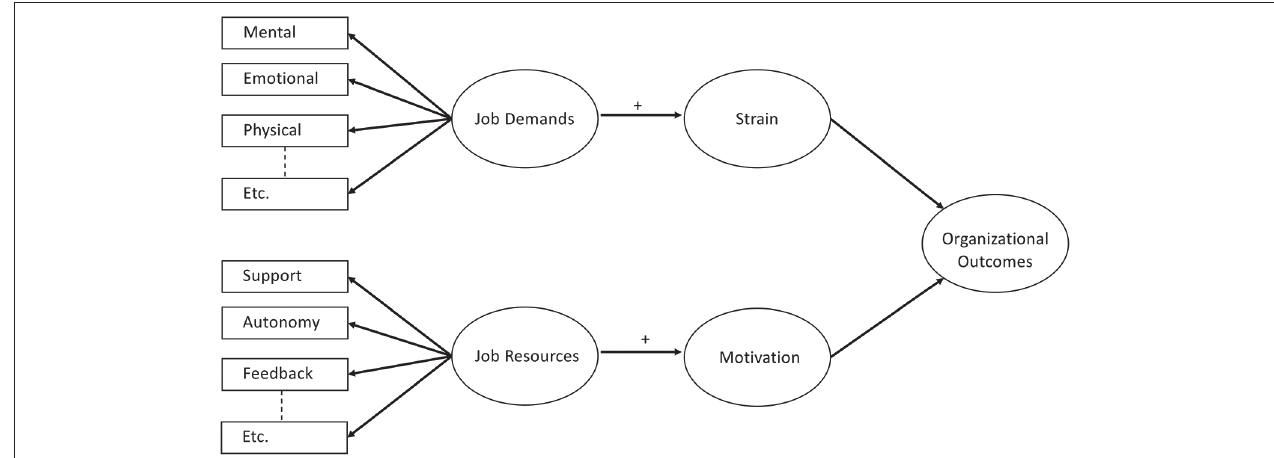
FIGURE 1 | Simplified Job Demands-Resources Model, adapted from Bakker and Demerouti